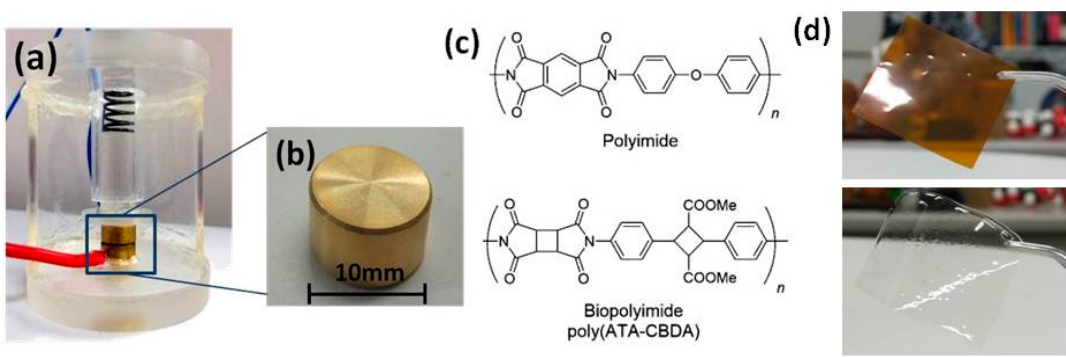
Figure 1. Photographs for ( a ) the laboratory-made cell and ( b ) the electrode for resistivity measurement for polyimide and biopolyimide films with sizes smaller than 40 mm square. ( c ) Chemical structures and ( d ) photographs of polyimide (top) and biopolyimide (bottom) films.